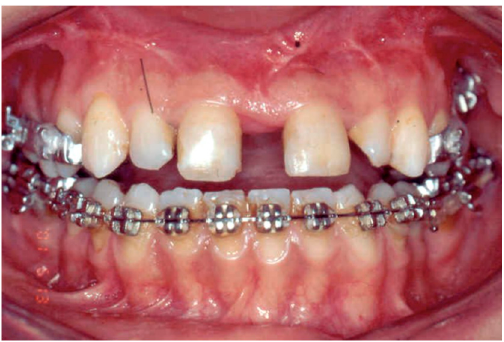
Figure 1. Sarpe activation and fixed theraphy initiated in the mandibular arch.